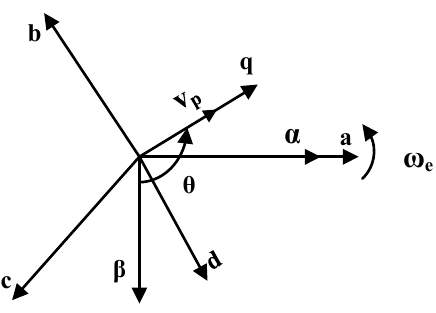
Figure 2. Space vector representation of PCC voltage. Grid disturbance with the voltage sag magnitude of xV m and yV m in ‘a’ and ‘b’ phases, respectively, gives the PSF voltages